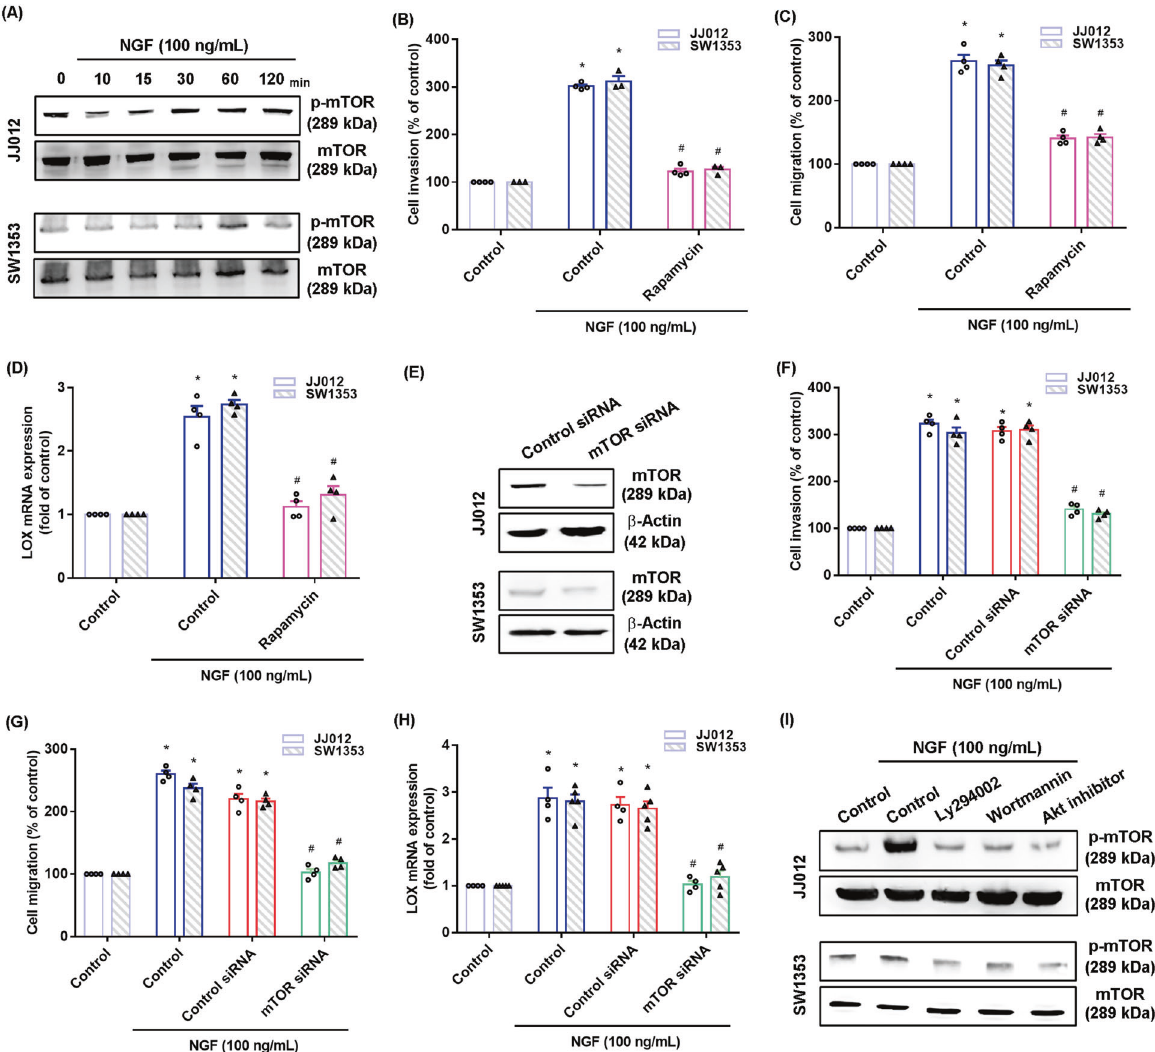
Fig. 4 PI3K/Akt-dependent mTOR activation mediates NGF-induced LOX expression and cell motility. A Cells were incubated with NGF for the indicated time intervals; mTOR phosphorylation was examined by western blot. B – D Cells were pretreated with an mTOR inhibitor (rapamycin) for 30 min, and then stimulated with NGF for 18 – 24 h. Cell migratory and invasive activities, as well as levels of LOX expression, were examined by Transwell and qPCR assays. E Cells were transfected with an mTOR siRNA and mTOR expression was examined by western blot. F – H Cells were transfected with a mTOR siRNA for 24 h, and then stimulated with NGF for 18 – 24 h. Cell migratory and invasive activities, as well as levels of LOX expression, were examined by Transwell and qPCR assays. I Cells were pretreated with PI3K and Akt inhibitors for 30 min, and then stimulated with NGF for 60 min; mTOR phosphorylation was examined by western blot. * p < 0.05 compared with the control group; # p < 0.05 compared with the NGF-treated